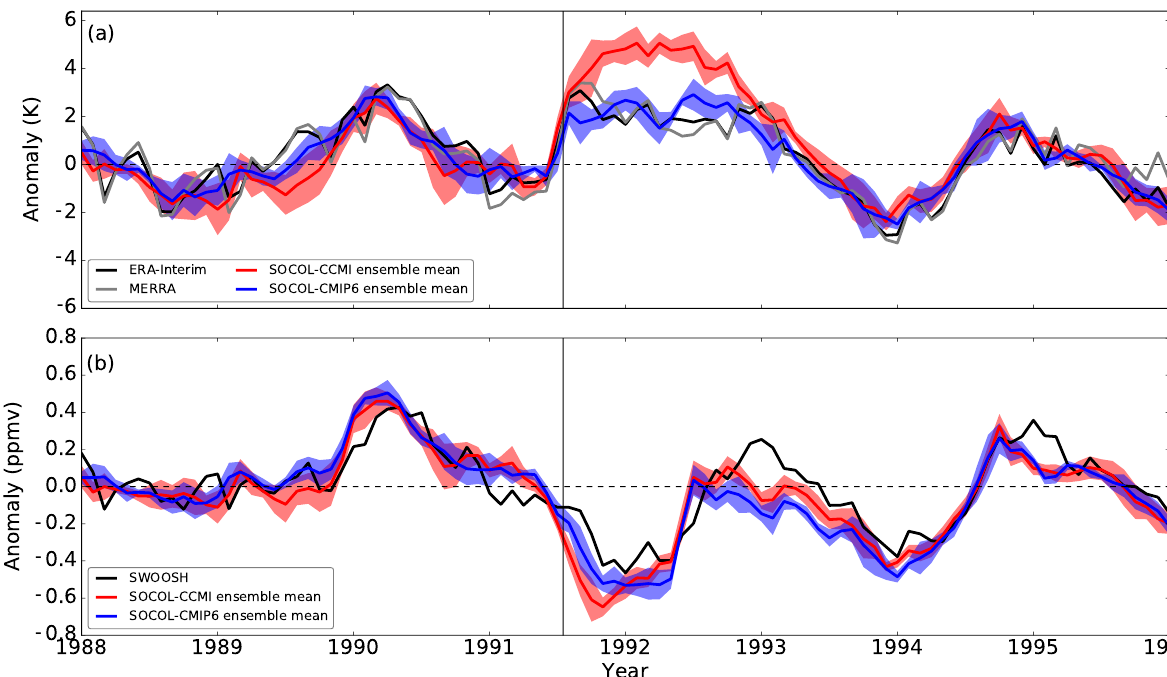
Figure 4. Time series of (a) temperature and (b) ozone anomalies at 30hPa, 15 ◦ N–15 ◦ S. The red and blue lines denote the ensemble mean of the SOCOLv3 CCMI and CMIP6 ensembles, respectively. The shaded areas denote the ensemble mean plus or minus 1 standard deviation of simulated anomalies, and the vertical lines show the timing of the Mt Pinatubo eruption on 15 June